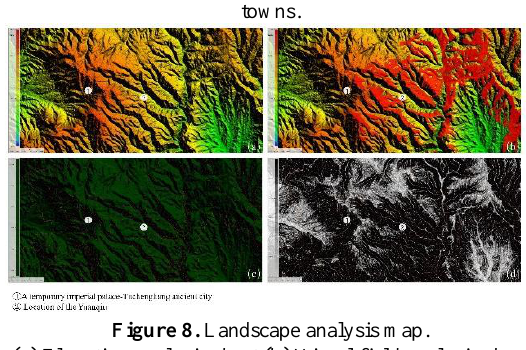
Figure 8. Landscape analysis map. (a) Elevation analysis chart (b) Visual field analysis chart (c) Vegetation cover analysis chart (d) Slope analysis